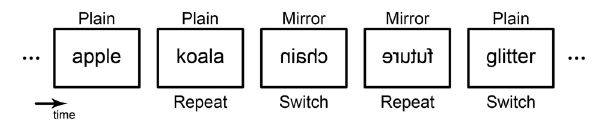
FIGURE 1 | Behavioral paradigm. Participants performed a living/non-living semantic judgment task for visually presented words. In some trials, words are mirror-reversed, in which they had to read the words in a novel (untrained) way, whereas non-reversed canonical forms (plain) of words are presented in other trials. These trials can also be classified as to whether the current trial type were repeated or switched from the preceding trial. The switch trials require immediate and flexible change of task skill from one to another, whereas repeat trials do not. Participant performed the identical paradigm during pre- and post-training